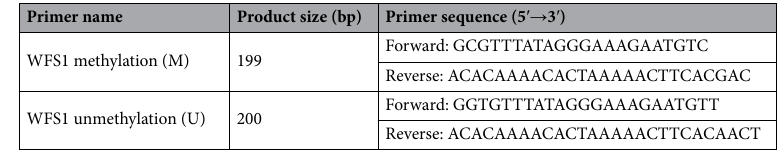
Table 3. Primers used for MSP